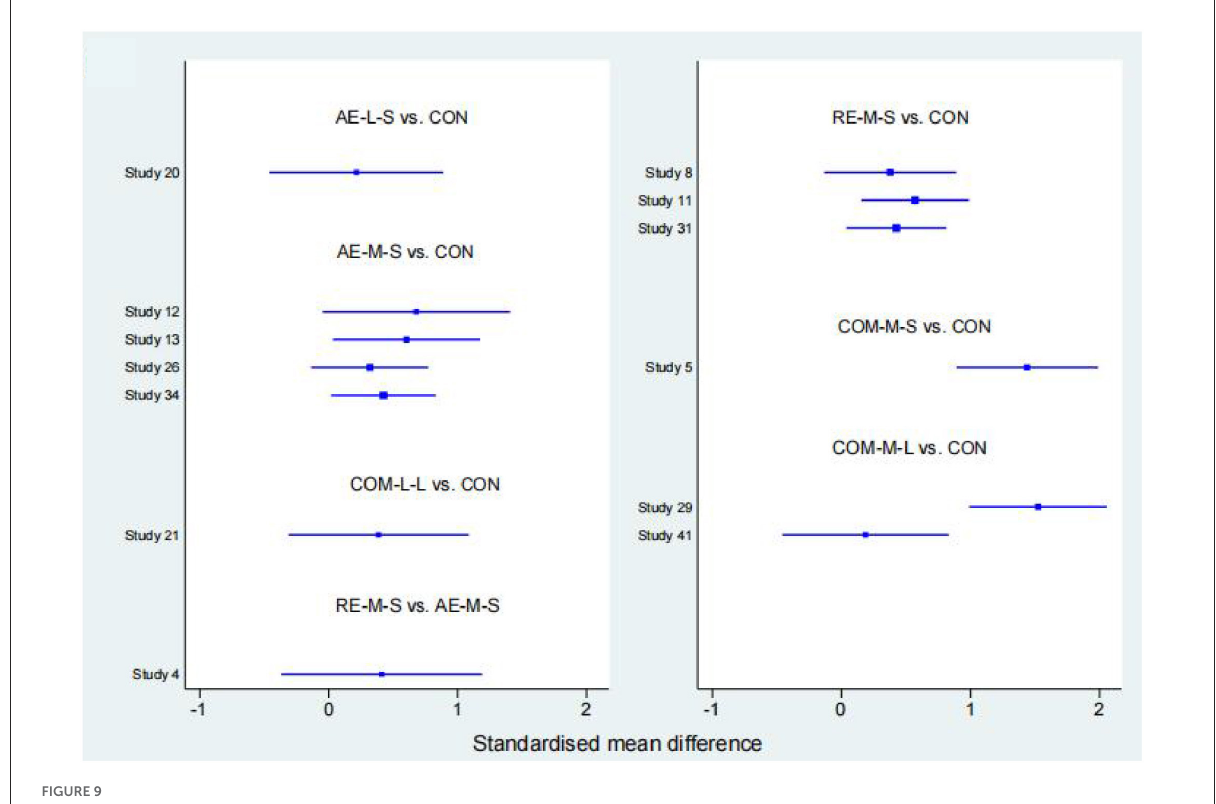
FIGURE9 The forest map for